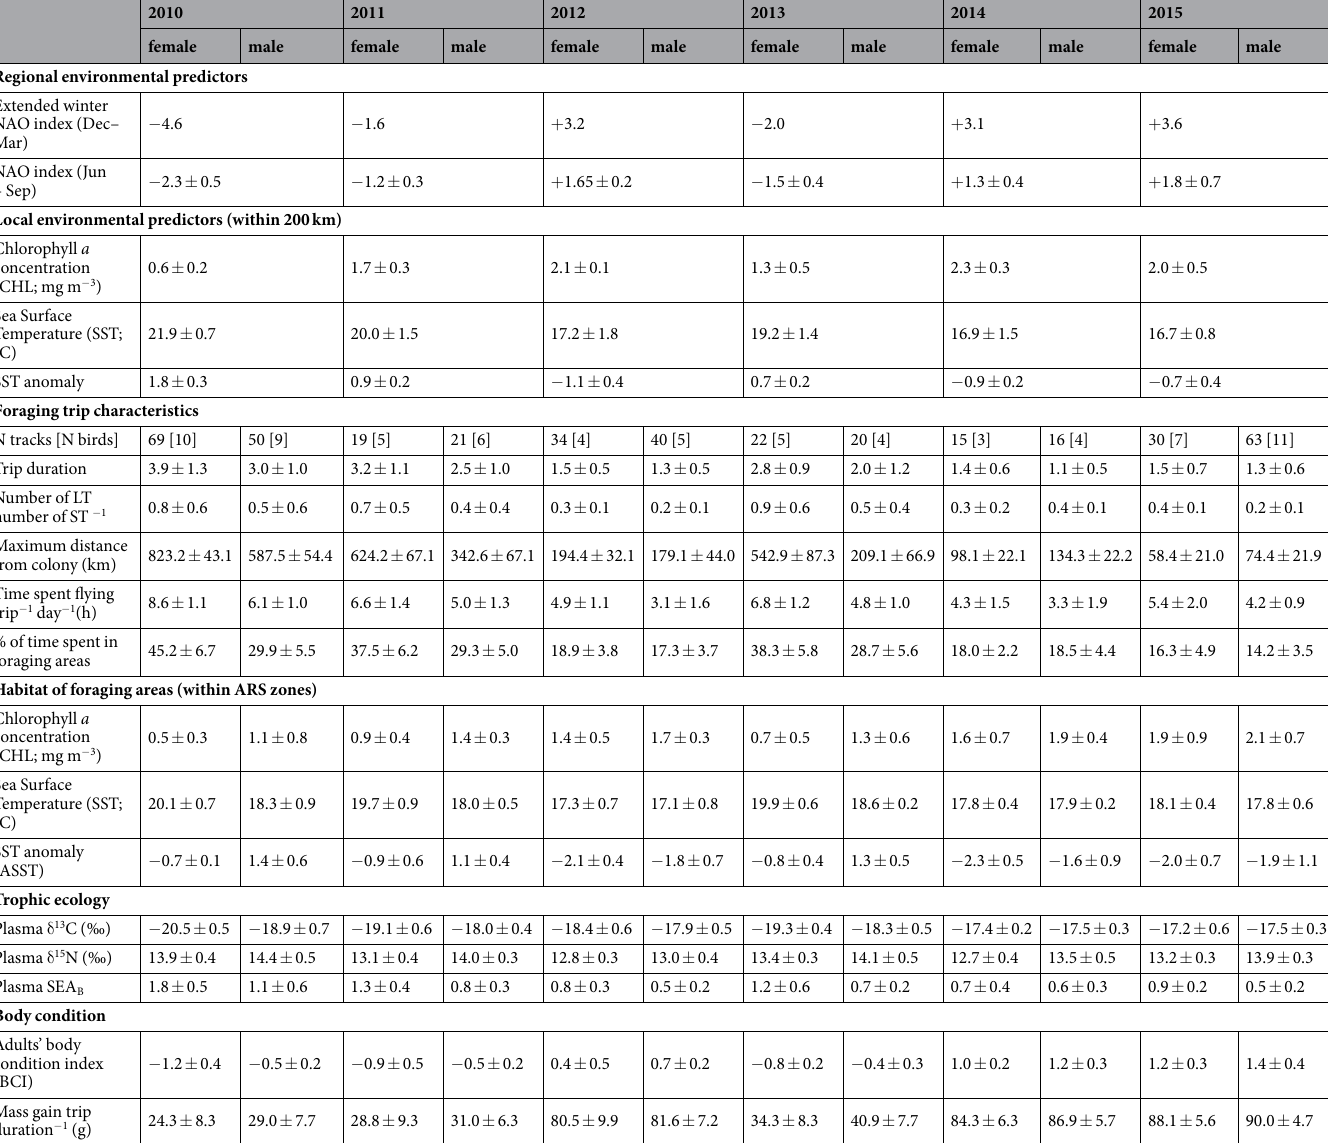
Table 1. Regional and local environmental predictors in the colony surroundings of female and male Cory’s shearwaters from Berlenga between 2010 and 2015; foraging trip characteristics, habitat of foraging areas, trophic ecology and body condition of both sexes. Extended winter (December-March) North Atlantic Oscillation (NAO) index according to Hurrell (https://climatedataguide.ucar.edu/climate-data/hurrell-north- atlantic-oscillation-nao-index-station-based). ARS – Area Restricted Search zones. LT – long trips ( ≥ 5 days of duration), ST – short trips ( ≤ 4 days of duration) as defined by ref. 24. Environmental predictors are for summer (June-September) of each year, unless otherwise stated. SEA B - Bayesian approximation of the standard ellipse area (see Jackson et al . 2011 for more details on these metrics of isotopic niche width). Values are mean ±